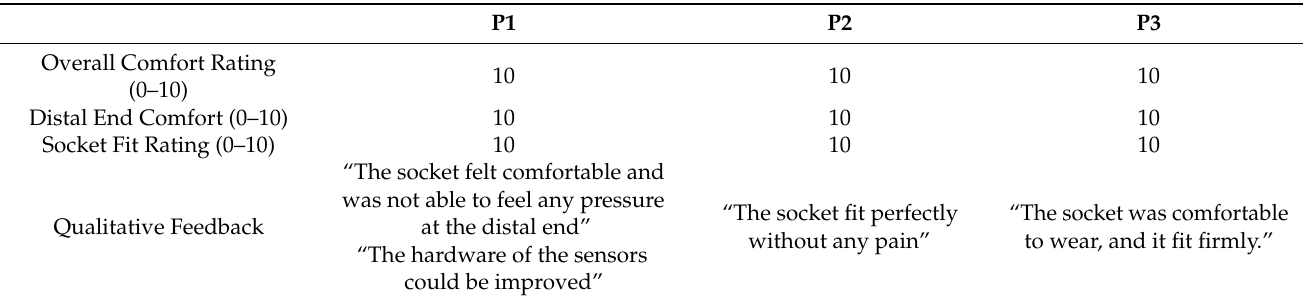
Table 3. Participants’ feedback with ratings for each criteria, ranging from 0 (not at all comfortable) to 10 (extremely